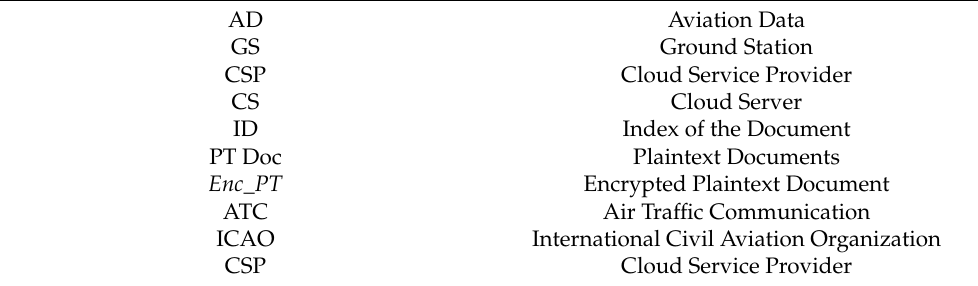
Table 1 highlights the important abbreviations and notations used in the proposed scheme. Table 1. Notations &